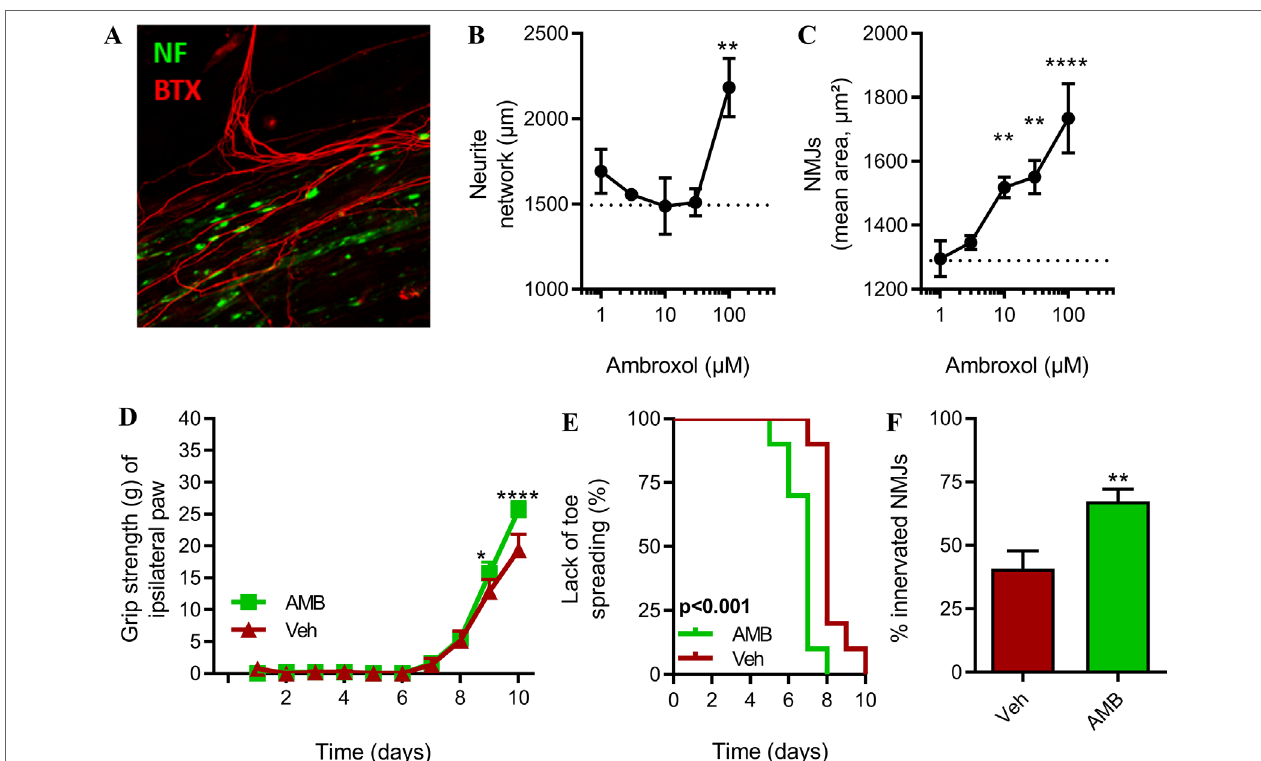
FIGURE 4 | Inhibition of GlcCer degradation by AMB improves in vivo axonal plasticity and nerve regeneration after sciatic nerve crush study in non-transgenic mice. (A) Representative picture of in vitro neuromuscular junctions (NMJs). (B) Total length of neurofilament-positive neurites and (C) total area NMJs ( n = 5/group). (D) Muscle strength of ipsilateral hind paws ( n = 10/group, * p < 0.05; **** p < 0.0001). (E) Kaplan–Meier showing time to observable toe spreading after sciatic nerve injury ( n = 10/group, p < 0.001). (F) NMJ integrity in tibialis anterior muscle ( n = 10/group, ** p <